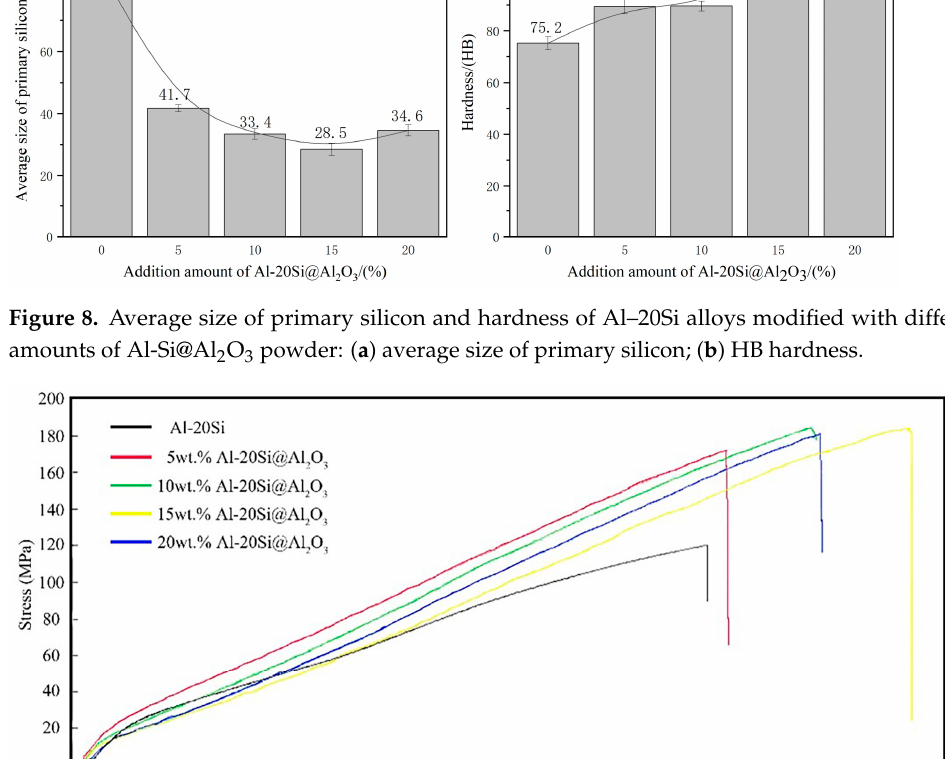
Figure 10. Tensile strength of Al–20Si with di ff erent additions. 3.4. Characterization of Microstructure of Modi fi ed Al-20Si Alloy Figure 11 shows the SEM and EDS image of Al-20Si alloy. The SEM and EDS image displayed in Figure 11. Figure 11a shows that many bright white spots are evenly distributed in the matrix of the Al–20Si alloy. From Figure 11b–d, it can be seen that these bright white spots are composed of Al and O elements. The TEM image shown in Figure 12 also reveals that numerous bright white spots are present in the Al–20Si alloy matrix. The crystal plane spacing calculated from Figure 12b is 0.239 nm, which is consistent with the (311) crystal plane spacing of γ -Al 2 O 3 . From Figure 13, it can be seen that the white spots on the surface of the Al–Si powder are composed of γ -Al 2 O 3 . The la tt ice mismatch between Si and γ -Al 2 O 3 is around 3%, and the γ -Al 2 O 3 particles can provide heterogeneous nucleation sites for primary Si phases. As the in situ synthesized γ -Al 2 O 3 particles usually possess a favorable we tt ability with the matrix, the primary Si phases can easily adhere to the γ -Al 2 O 3 substrate for nucleation and growth, which im- proves the nucleation e ffi ciency of γ -Al 2 O 3 . This is also the main reason why the primary silicon in the Al-20Si alloy is obviously re fi ned.